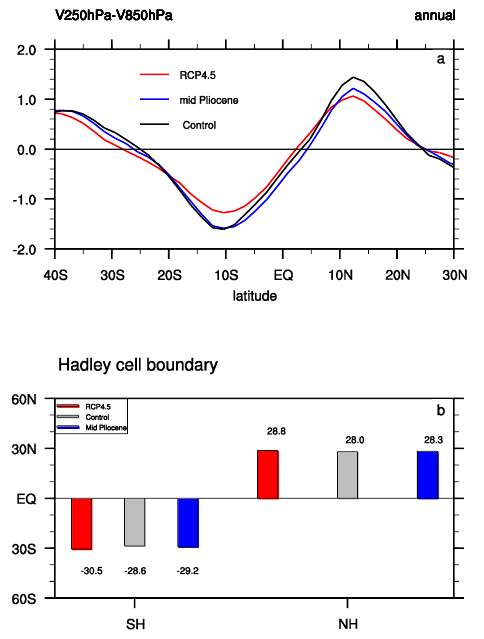
1 Fig. 2. (a) Simulated vertical shear of meridional wind (V250– Fig.2 (a) simulated vertical shear of meridional wind (V250-V850) derived from three 2 V850) derived from three different simulations (control run, different simulations (Control run, RCP4.5 and mid-Pliocene). (b) Hadley cell edges 3 RCP4.5 and mid-Pliocene). (b) Hadley cell edges in the three ex- in the three experiments. 4 periments. Fig. 3. Climatological annual average potential velocity (contours;